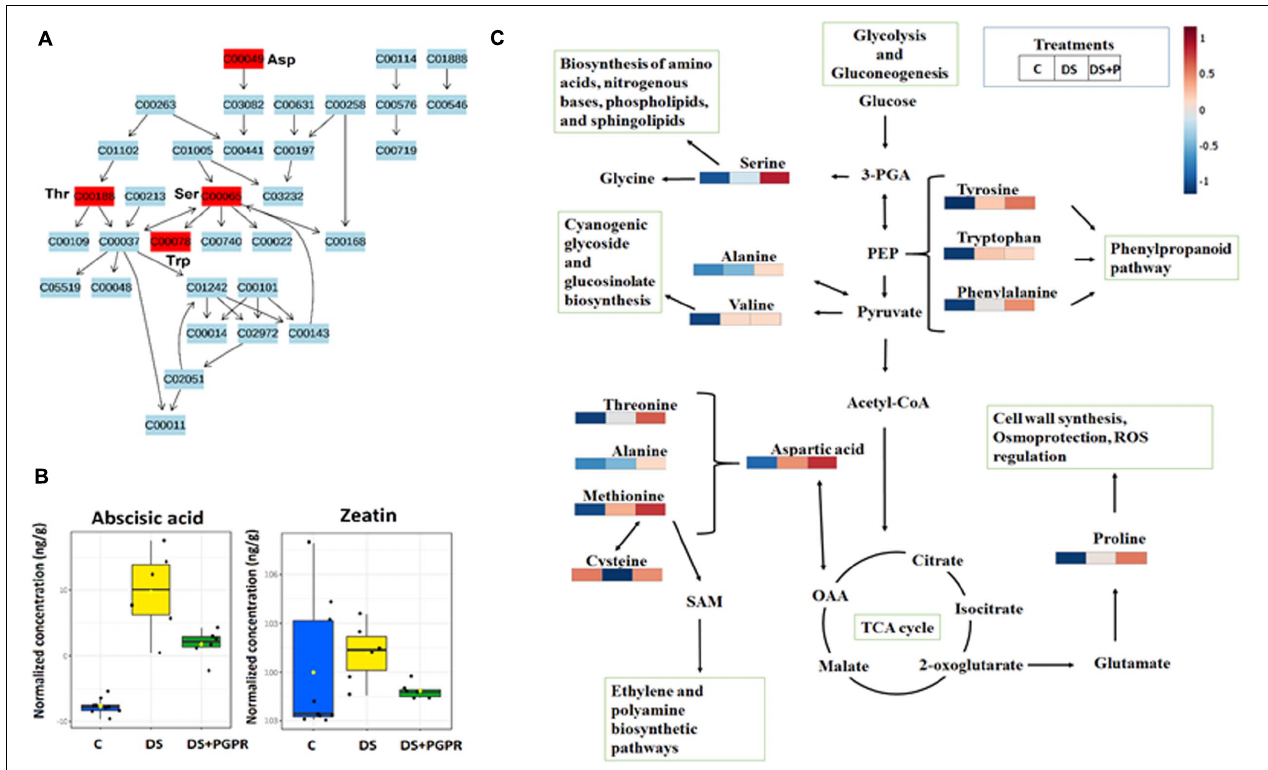
FIGURE 5 | Metabolic pathway analysis and mapping. (A) Topology map of glycine, serine and threonine metabolism. (B) Boxplots showing the quantification levels of selected phytohormones, abscisic acid and zeatin. (C) Amino acids and related metabolic pathways: infographics that show the quantitative changes of amino acids induced by PGPR and their relational properties to other pathways such as citrate (TCA) cycle, phenylpropanoid biosynthesis, polyamine synthesis and glycolysis and gluconeogenesis. C, control: naïve non-stressed; DS, naïve stressed plants; DS + P/PGPR, PGPR- treated stressed